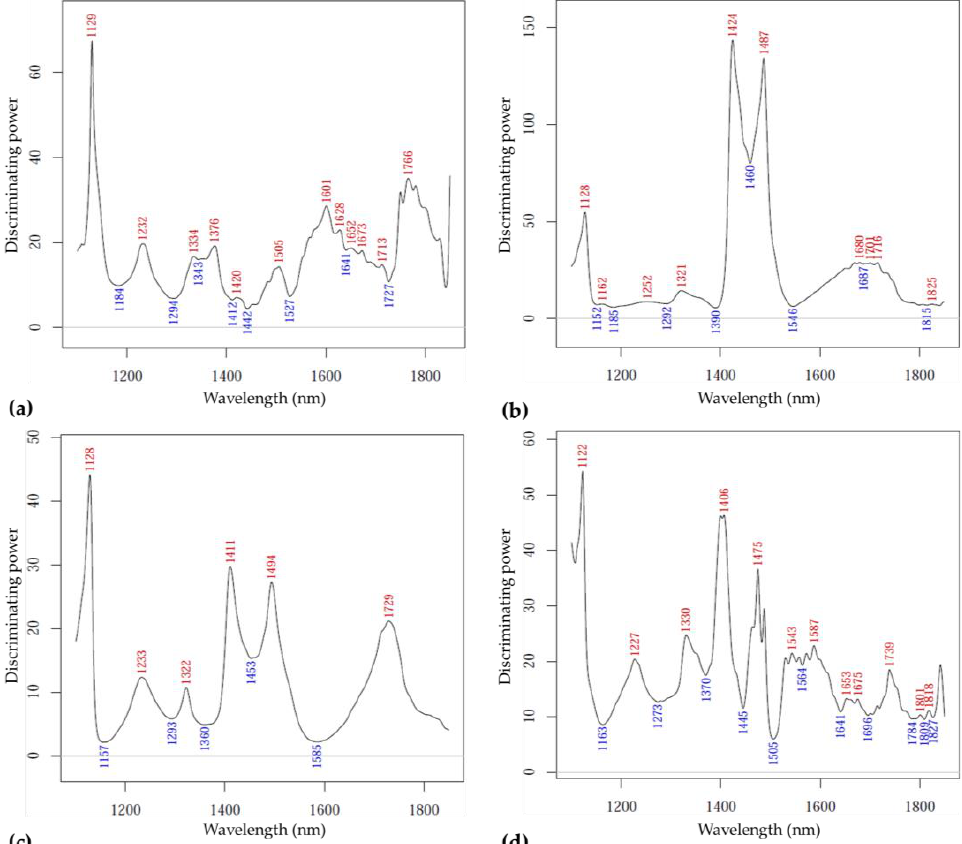
Figure 10. The SIMCA discriminating power plots for storage time: ( a ) control ‘Kántorjánosi’ samples ( n = 88, k = 3); ( b ) control ‘Újfehértói fürtös’ samples ( n = 84, k = 2); ( c ) MAP ‘Kántorjánosi’ samples ( n = 81, k = 1); ( d ) MAP ‘Újfehértói fürtös’ samples ( n = 83, k = 3).